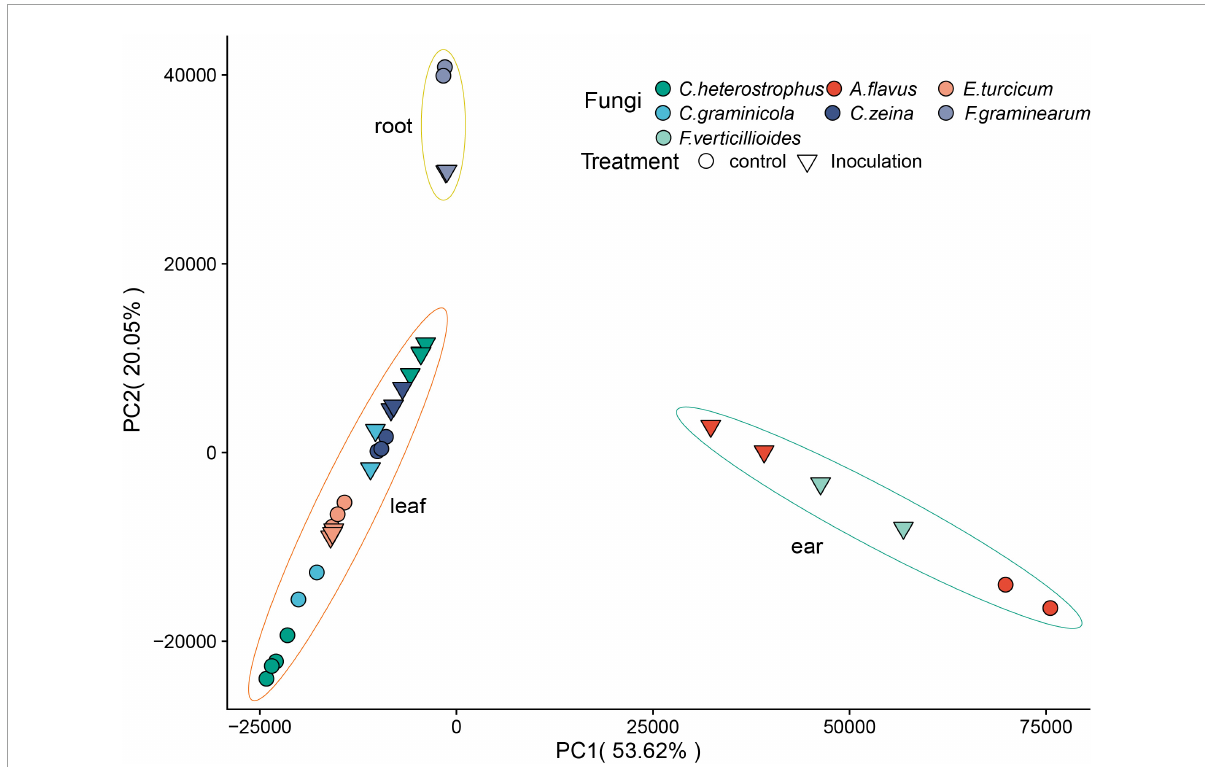
FIGURE2 Principal component analysis of RNA-seq data. The treatment conditions and fungi are indicated by different symbols/colors in the plot.